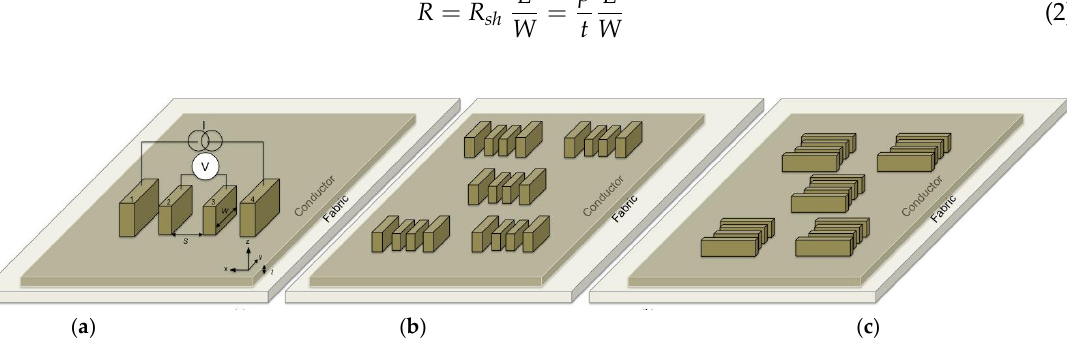
Figure 2. ( a ) Four-point probe setup and the placement of the probe at five different positions in the ( b ) weft and ( c ) warp directions in the 4PP